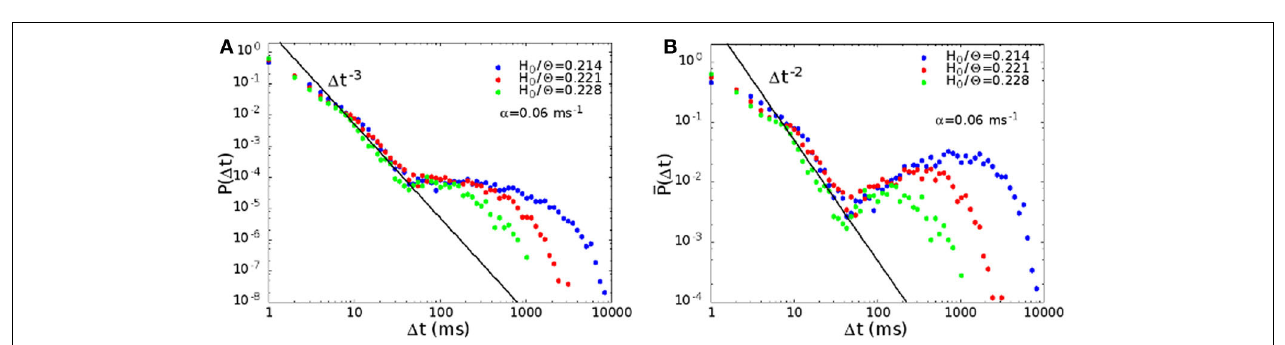
H 0 /(cid:4) = 0 . 221 corresponds to point B in Figure 2B , while the green and blue curves to points next to point B to the right and to the left. (B) Same data of (A) , with a different definition of the probability distribution ¯ P ( (cid:10) t ) (see